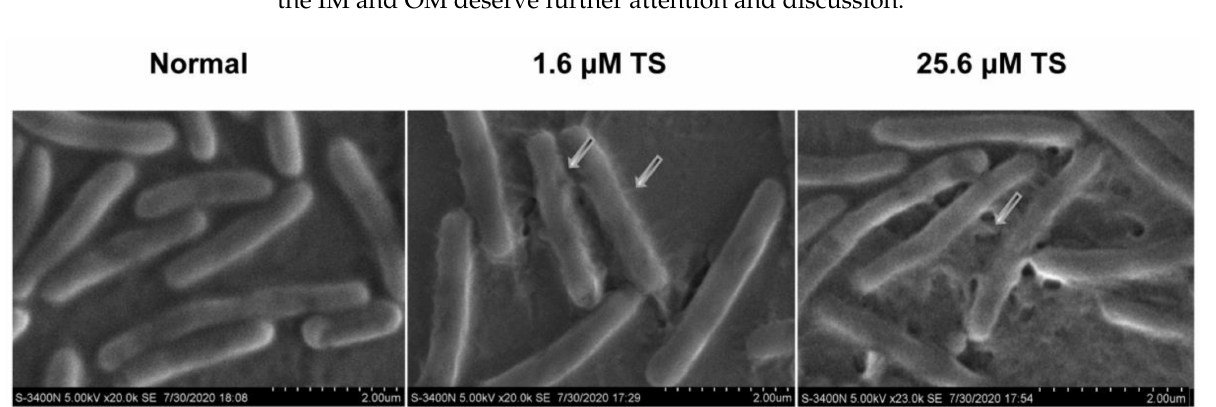
Figure 4. Scanning electron microscopy of E. coli ATCC 25922 and E. coli ATCC 25922 treated with 1.6 µ M or 25.6 µ M of antimicrobial peptide